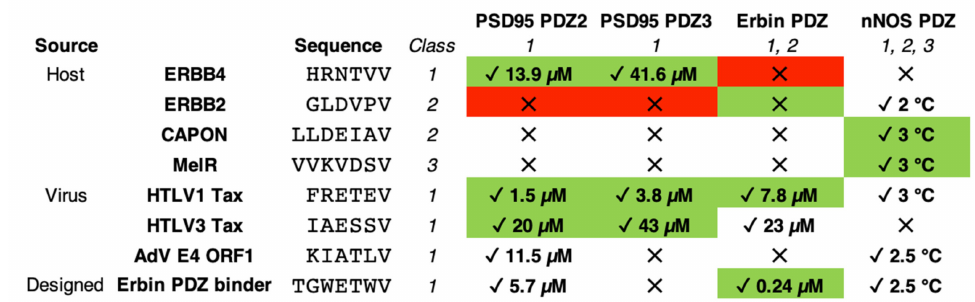
Figure 1. The PDZ domains and the ligands used in this study. The ligands are grouped by their sources (host, virus or design) and are noted with both their respective names and amino acid sequences. The color fill means that the interaction has been previously described (green), or has also been demonstrated not to occur (red). If there is no fill, the interaction has not been studied according to bibliography, to the best of our knowledge (the references for the described interactions are in the text). The tick ( (cid:51) ) and the cross ( (cid:53) ) signs mean whether there is interaction or not, respectively, as demonstrated in this study. We have included the K d in µ M or the ∆ T m in ◦ C, whenever an interaction has been shown by ITC or DSC, respectively (see Sections 3.2 and 3.3 for